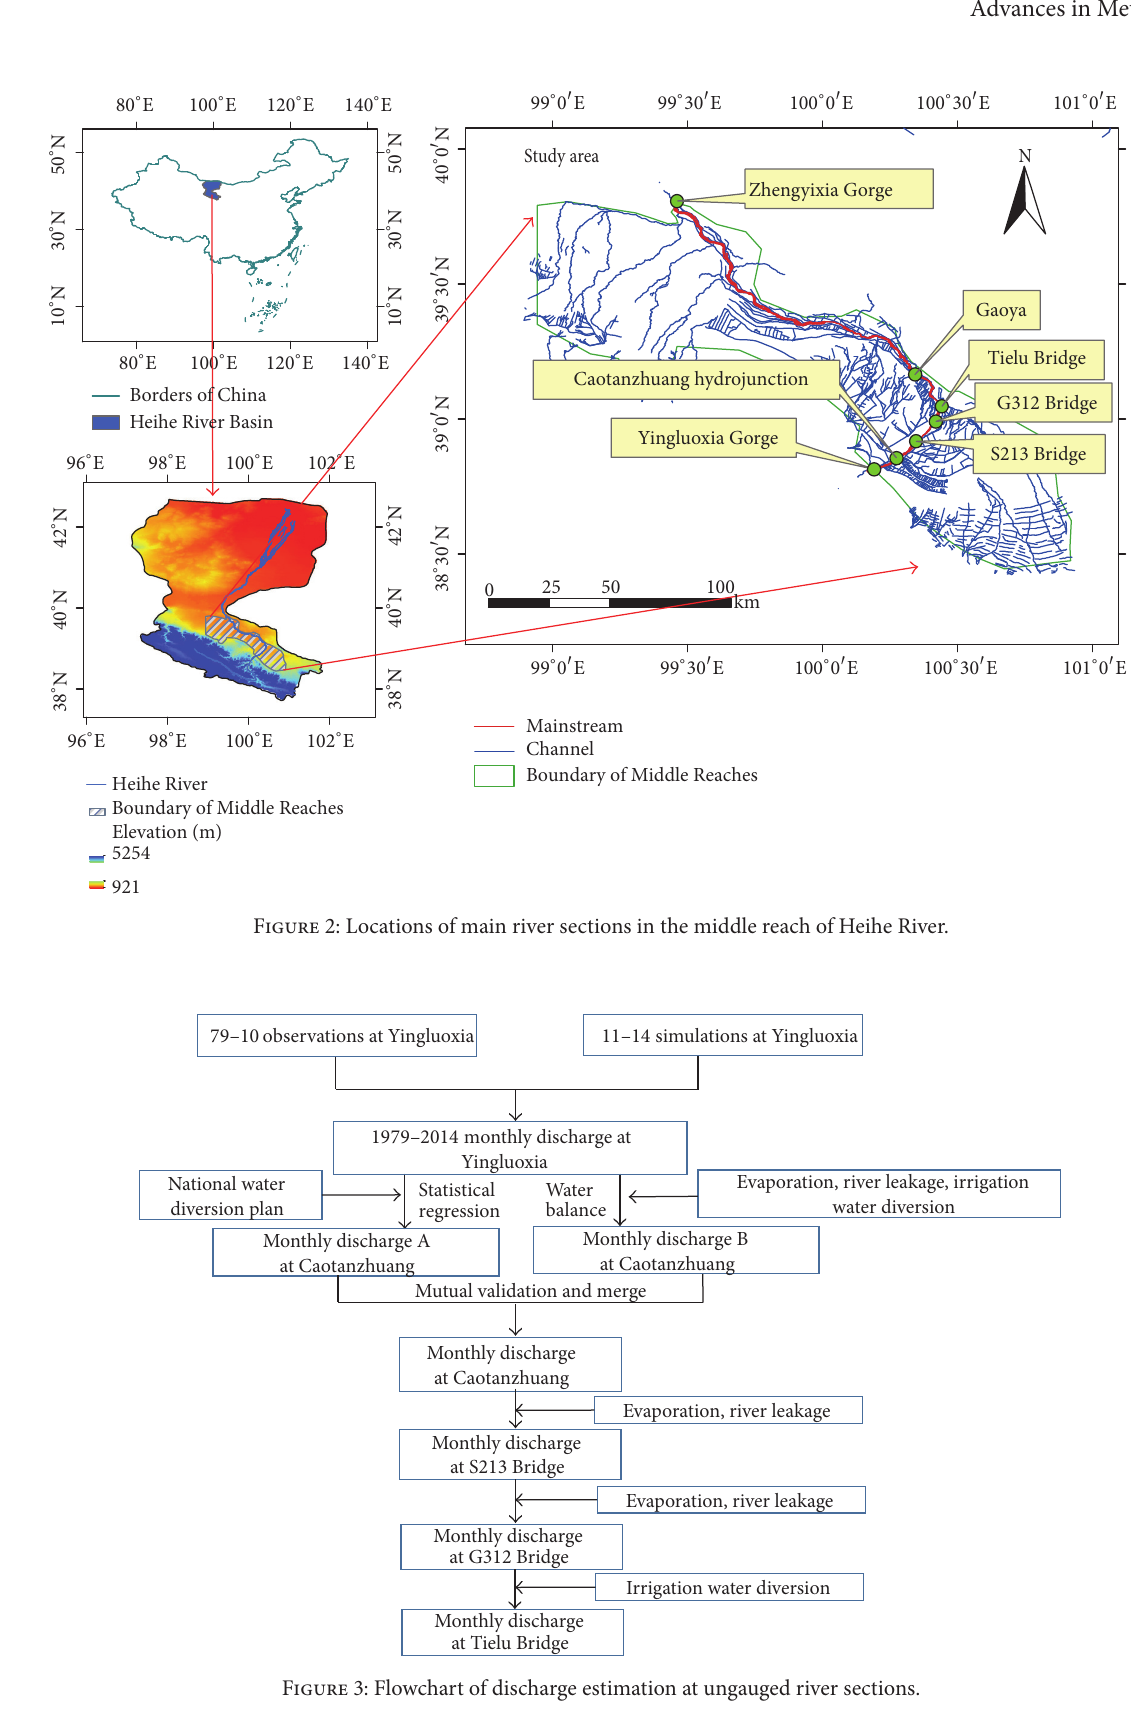
Figure 3: Flowchart of discharge estimation at ungauged river